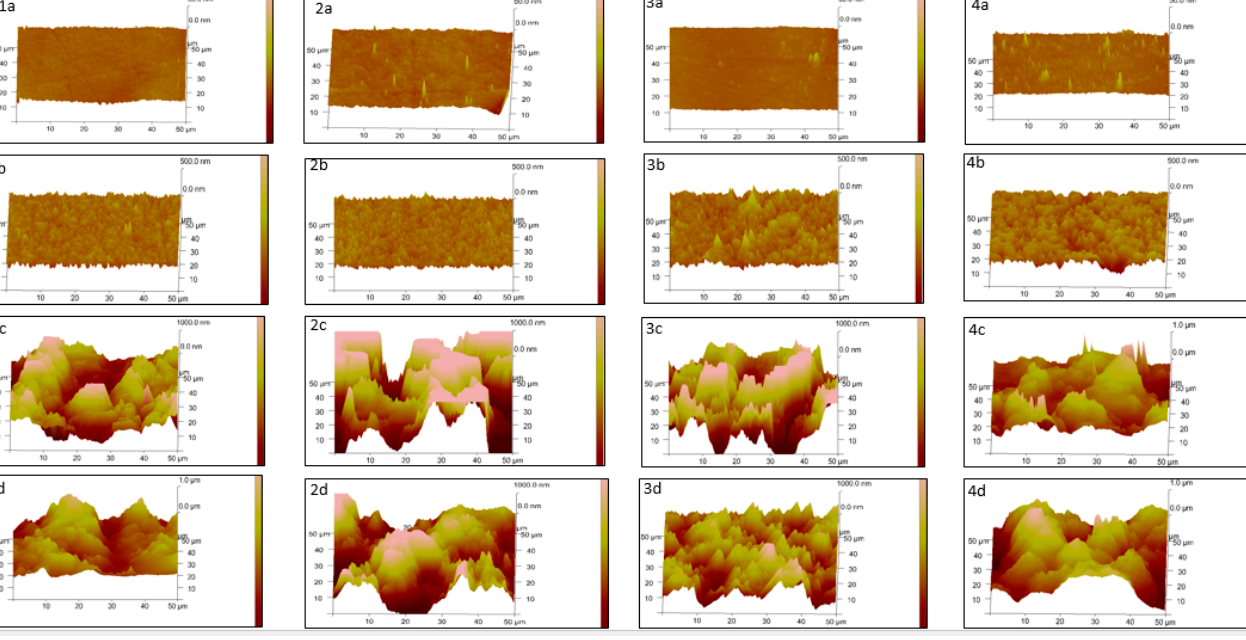
Figure 3. Mean of different surface roughness on lithium silicate-based glass-ceramic. 4. Discussion A reliable bond between resin cement and glass-ceramic restorations contributes to the longevity of glass-ceramic restorations and their overall clinical success [18]. Several studies focused on cement selection and the use of silane coupling agents to improve the bonding between resin cement and glass-ceramic [19–22]. However, there are many LSGC used for the fabrication of indirect dental restorations and still lacking supportive evi- dence for its functionality. The ideal clinical protocol for predictable bonding between resin cement and lithium disilicate-based glass-ceramic restoration remains undeter- mined. The surface treatment of glass-ceramic restorations before cementation is an es- sential step to improve the clinical performance of LSGC restorations. Increasing the sur-